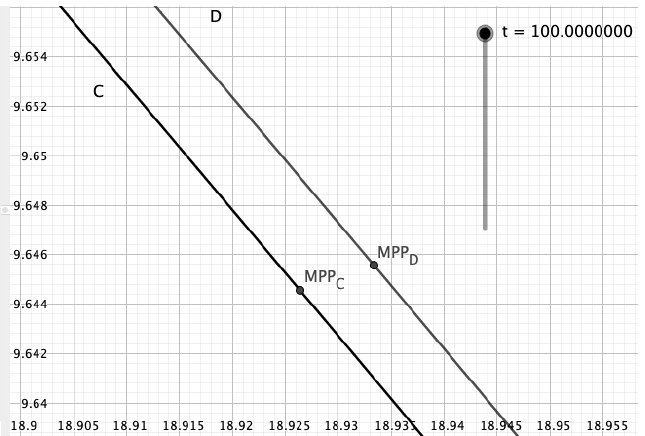
Figure 5. Curve D = D IV , t results from using constant series resistor R s , T value increase with factor T